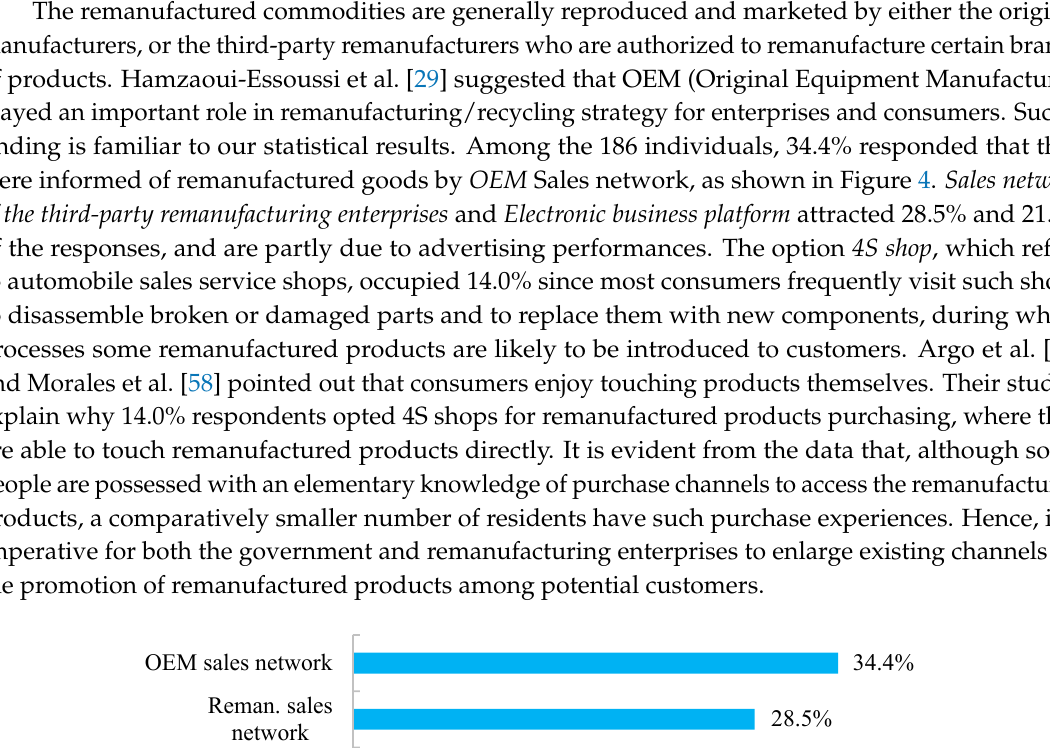
Figure 4. Sales network of the third-party remanufacturing enterprises and Electronic business platform